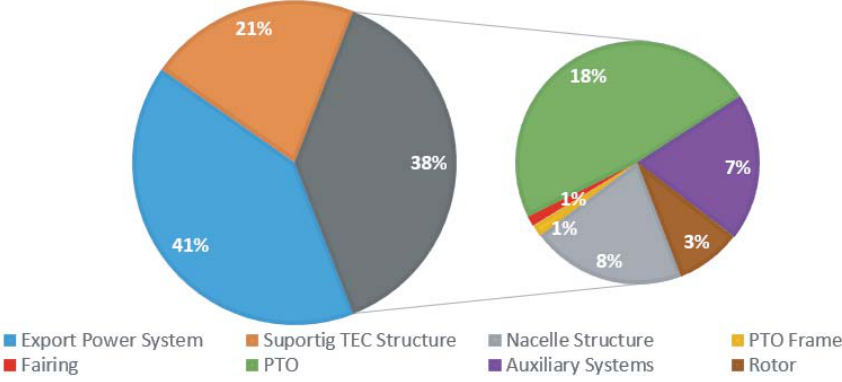
Figure 11. Manufacturing costs of the